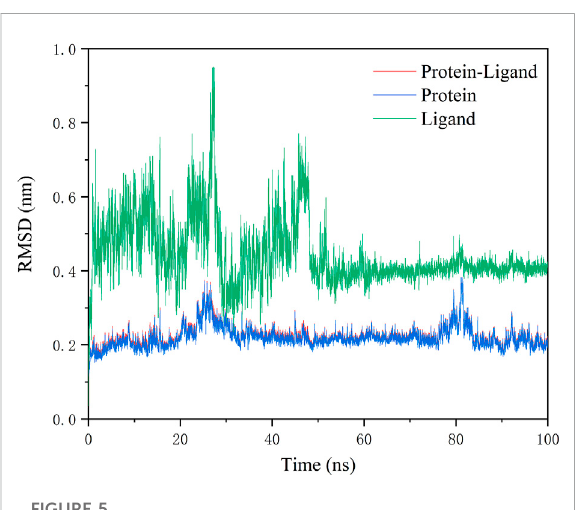
FIGURE 6 Residue-based fl uctuations of protease backbone of complexes over 100 ns